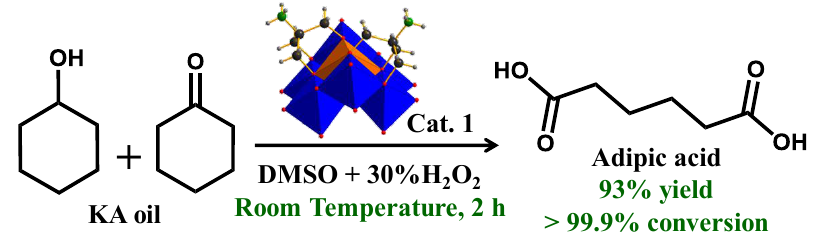
Scheme 1. One-pot selective oxidation of KA oil (cyclohexanone and cyclohexanol mixture with a mole ratio of 2:1) towards adipic acid catalyzed by β -{[H 3 NC(CH 2 O) 3 ] 2 MnMo 6 O 18 } − ( 1 ). Colour code: Mo, blue; Mn, orange; O, red; N, green; C, black; H, gray.